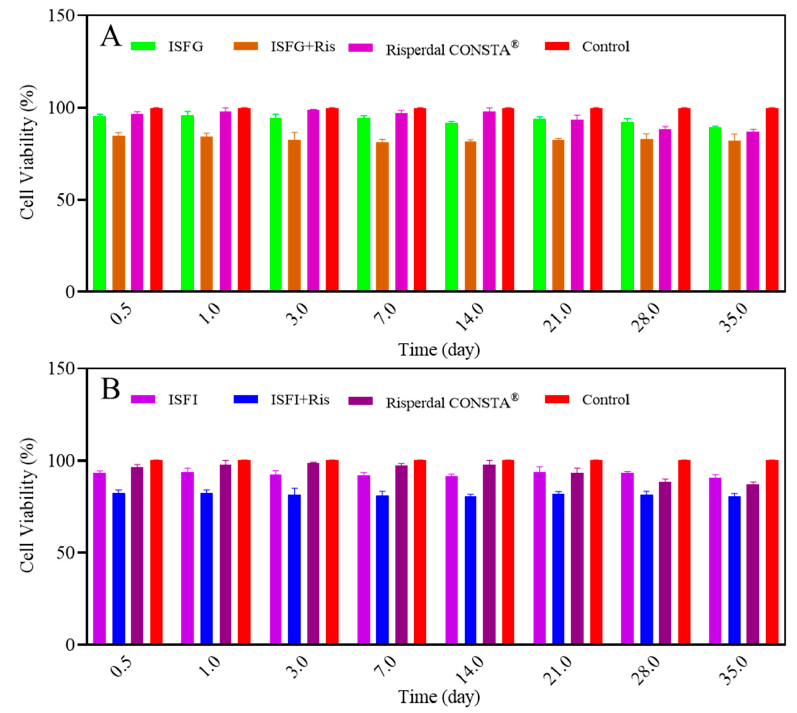
Figure 4. Evaluation of L-929 cell viability in the presence of in vitro release medium of ISFG ( A ) and ISFI ( B ) and Risperdal CONSTA ®